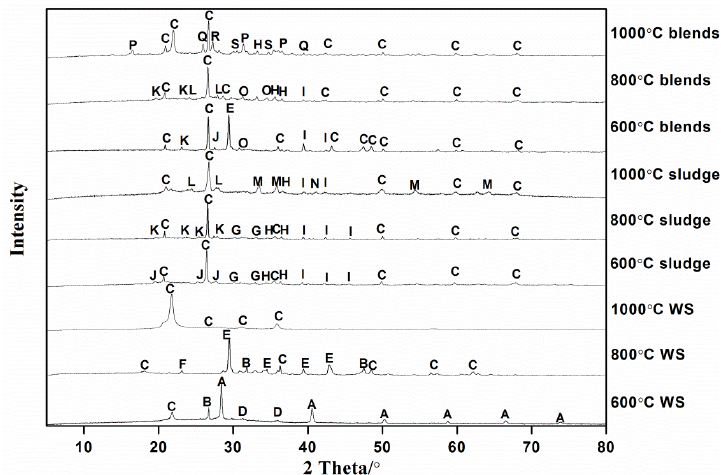
Figure 3. XRD patterns of the ash samples A-KCl, B-CaSiO 3 , C-SiO 2 , D-Na 2 MgCl 4 , E-K 2 SO 4 , F-K 2 Si 2 O 5 , G-Al 2 SiO 5 , H-Ca 3 (PO 4 ) 2 , I-Fe 2 O 3 , J-KAl 2 Si 3 AlO 10 (OH) 2 , K-KAlSiO 4 , L-KAlSi 3 O 8 , M-3Al 2 O 3 · 2SiO 2 , N-Ca 9 Fe(PO 4 ) 7 , O-K 4 Ca(PO 4 ) 2 , P-KAlSi 2 O 6 , Q-KFeSi 3 O 8 , R-CaAl 2 SiO 6 , S-Ca 7 Mg 2 P 6 O 24 .